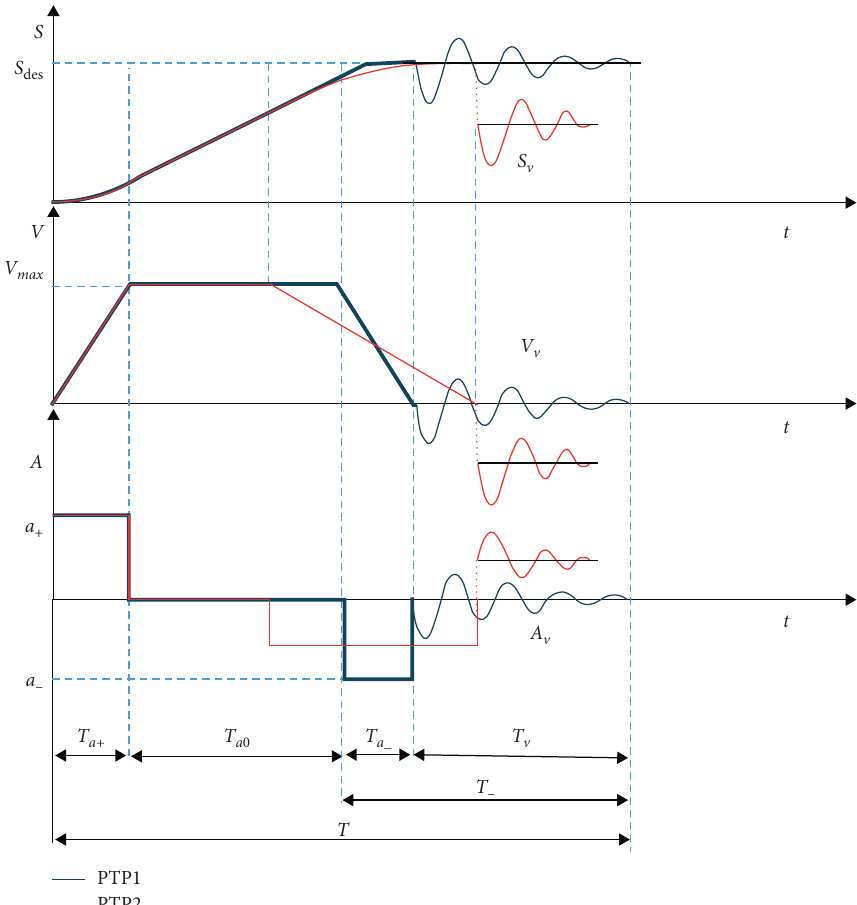
Figure 3: Schematic diagram of the residual vibration of the trapezoidal moving profile.